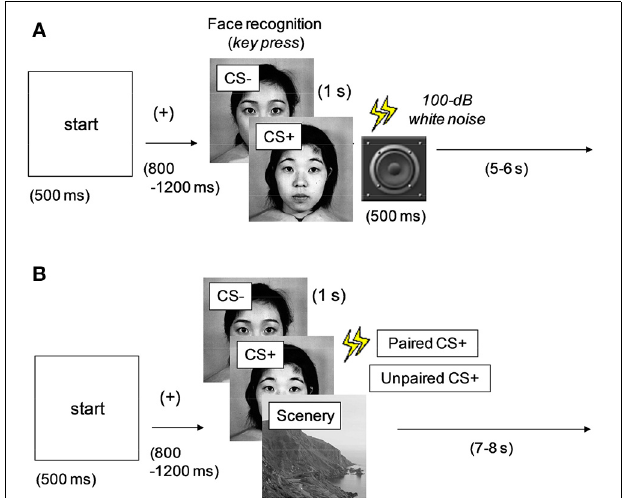
FIGURE 1 | Experimental procedures in the (A) conditioning and (B) data acquisition phases. One of the multiple images was presented at every trial. CS + , aversively conditioned face stimuli; CS − , unconditioned stimuli. All the faces were neutral; CS + was followed by a noise burst in (A) (all) and (B)